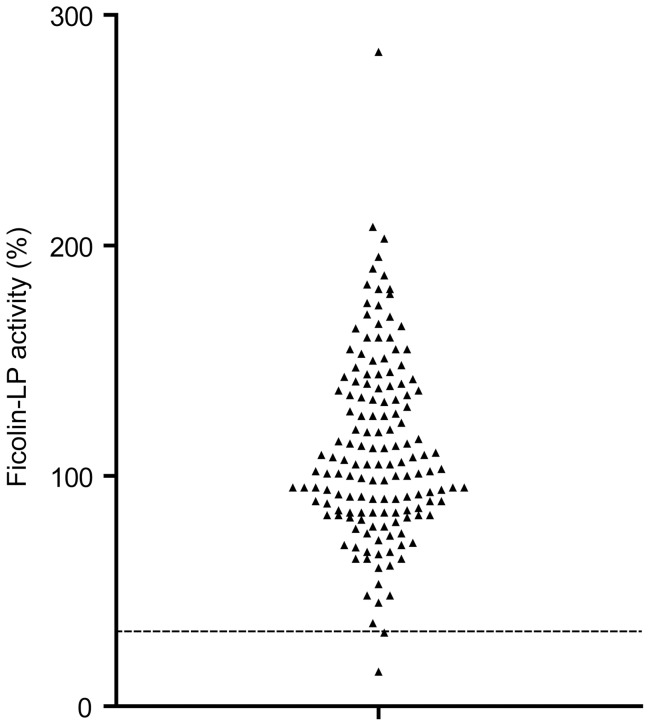
Ficolin lectin pathway activity (%) in the control group of healthy blood donors (n = 150).The dotted line indicates the lower cut-off value for normal activity. The cut-off value for the Ficolin lectin pathway activity was defined from the lower limit of a 95% confidence interval.